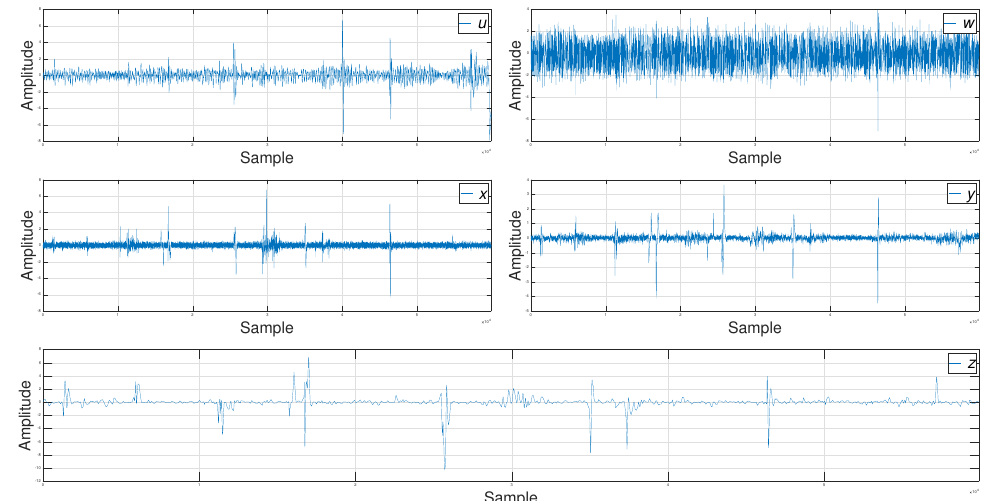
Figure 8. Control error time series collected from real large-scale ammonia synthesis